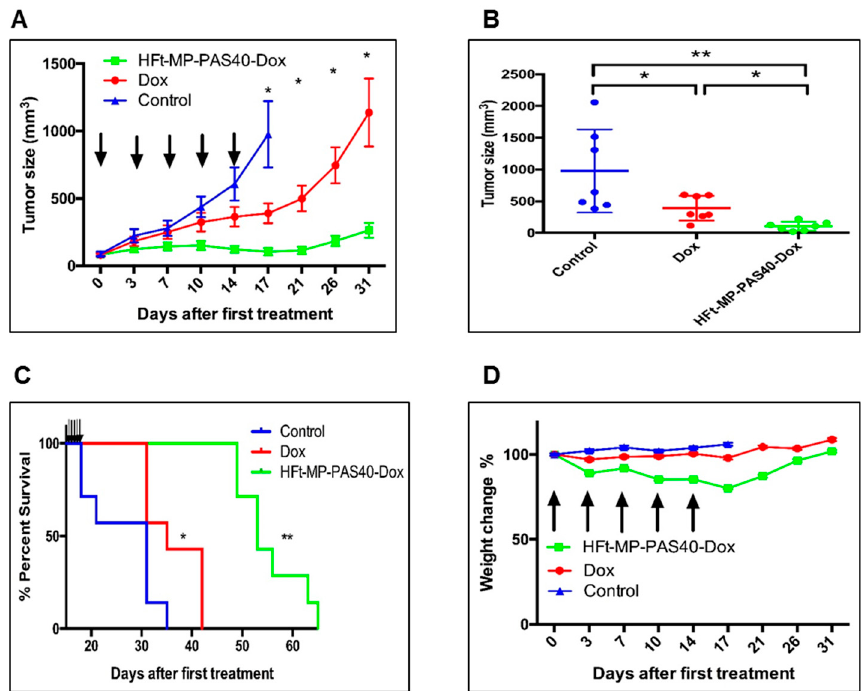
Figure 3. Anti-tumor activity of HFt-MP-PAS40-Dox in mice bearing FaDu tumors. ( A ) Tumor-growth curves for mouse groups are indicated. Student’s t -test is used to determine the statistical significance. * p < 0.05 and ** p < 0.001; ( B ) Single animal tumor sizes at day 17; ( C ) Survival curves of different animal groups bearing FaDu tumors. Animals were sacrificed when the tumor had reached a volume of ≥ 1500 mm 3 . Statistical analysis was performed by Log-rank test. Control vs. Dox * p < 0.05. Control vs. HFt-MP-PAS40-Dox ** p < 0.001. Dox vs. HFt-MP-PAS40-Dox ** p < 0.001. Arrows indicate the five treatments (5 mg/kg Dox equivalents); ( D ) Body weight changes of tumor-bearing mice after treatments.